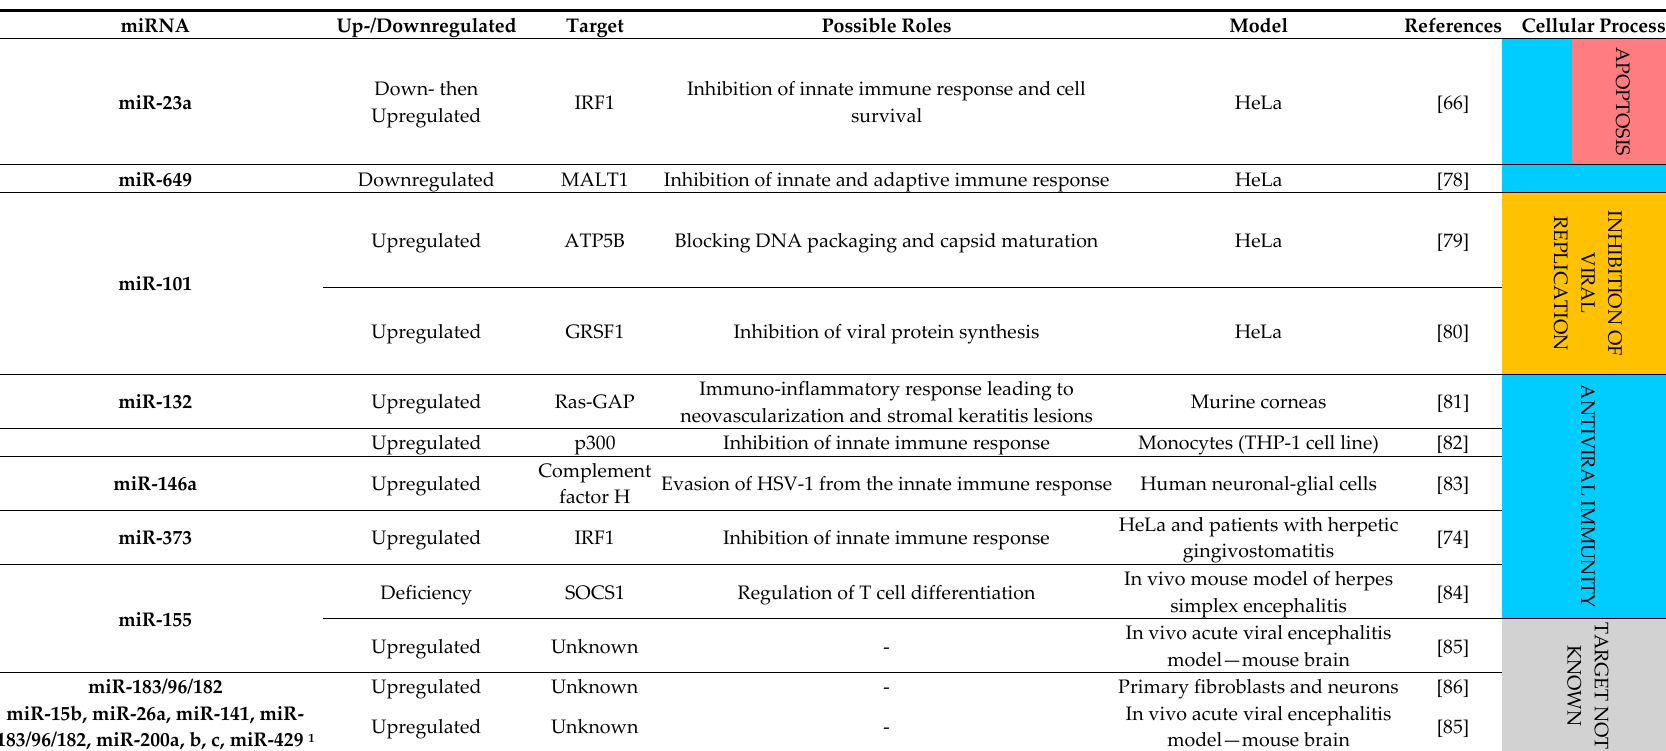
Table 1. Host microRNA (miRNA) deregulated in herpes simplex virus 1 (HSV-1) infection and their targets.